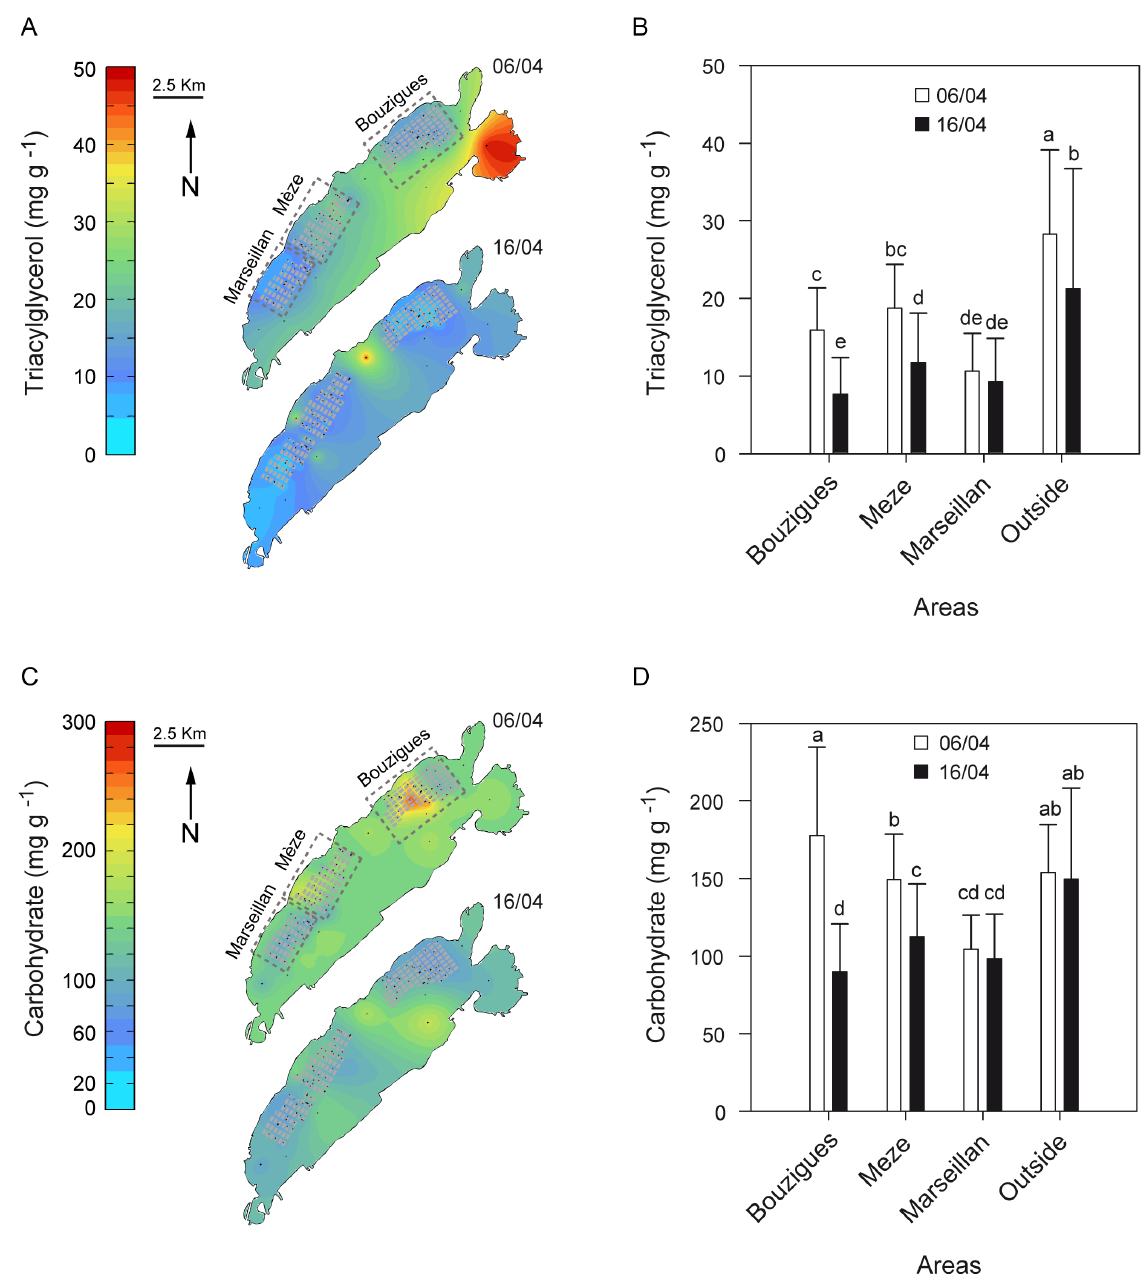
Figure 3. Energetic reserves of oysters in the Thau lagoon. (A, C) Kriged maps of the triacylglycerol and carbohydrate levels in oysters in the Mediterranean Thau lagoon measured on 6 April when seawater temperature reached 16 u C, and 16 April at the beginning of the mass mortality phenomenon. Black points represent sampling sites, areas with grey boxes represent individual bivalve farms and dashed rectangles correspond to the three farming areas. (B, D) Triacylglycerol and carbohydrate levels of oysters as a function of time and area in the Thau lagoon. Letters indicate significant differences. Data are means 6 SD.